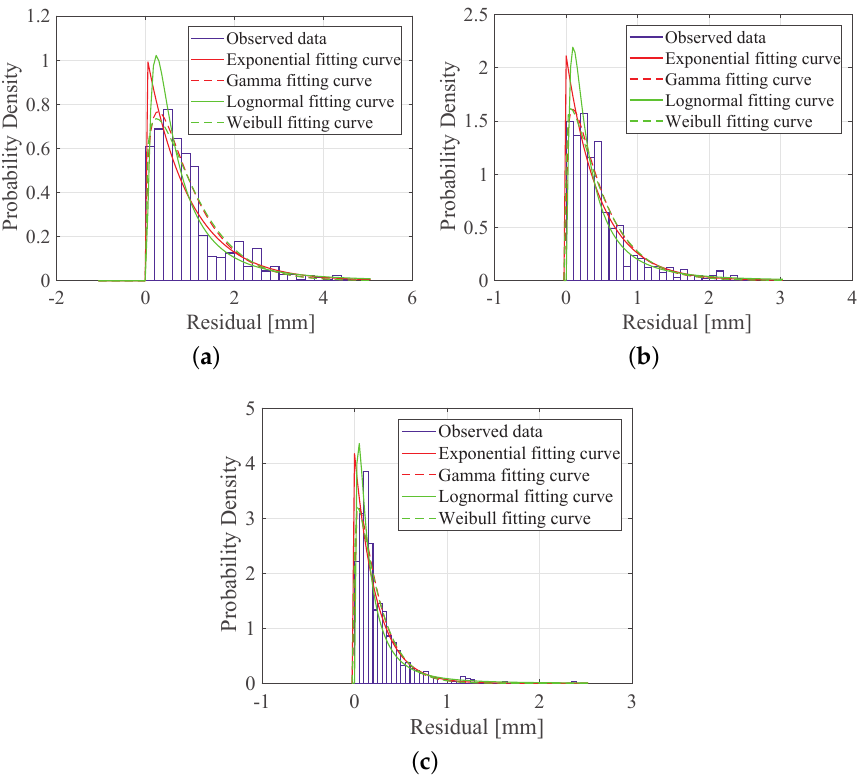
Figure 13. Univariate PDF fitting curves of ( a ) | ε | 9 − 3 , ( b ) | ε | 9 − 4 and ( c ) | ε | 9 − 5 .